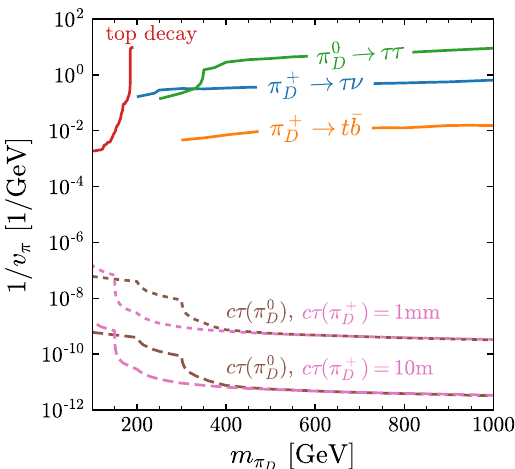
Figure 5 . Constraints on the value of 1 /v as a function of the dark pion mass. Precise measure- π ments of the top quark exclude regions above the red line. The green, blue, and orange lines come from collider searches for heavy Higgs particles (mainly in 2HDM). Lastly, the brown and pink dashed lines are not constraints, but show at what point the phenomenology changes. Below these lines, the pions start to travel an appreciable distance in the detector, either leading to displaced vertices or disappearing tracks. The lower of these lines are around the scale when the particles leave the detector either as missing energy or look like stable charged